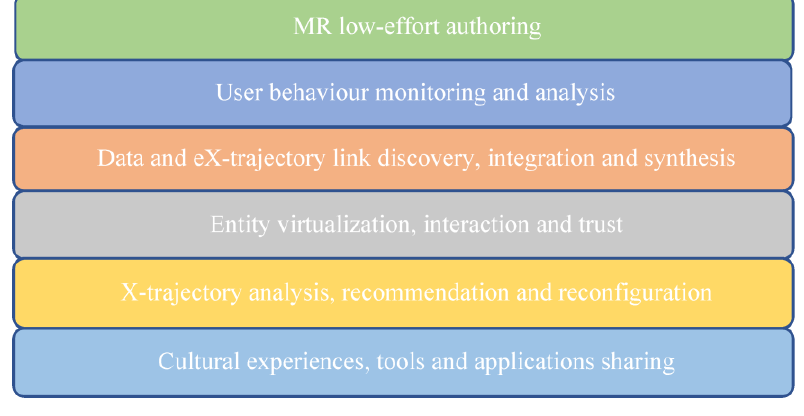
Figure 3. SemMR key technologies.